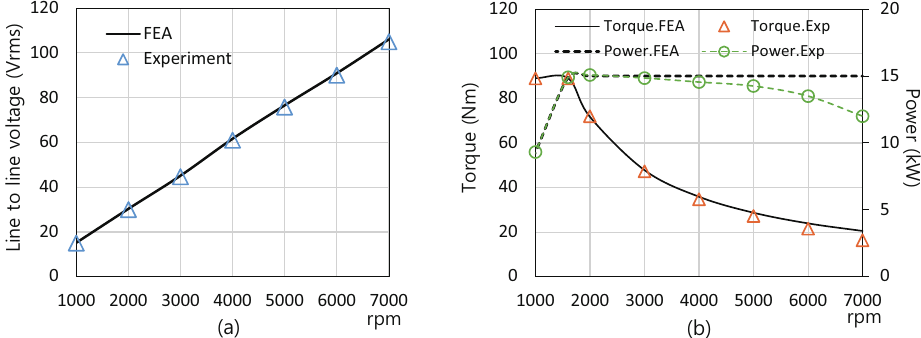
Figure 13. Comparison between FEA results and experiment results: ( a ) magnitudes of back EMF and ( b ) torque-speed